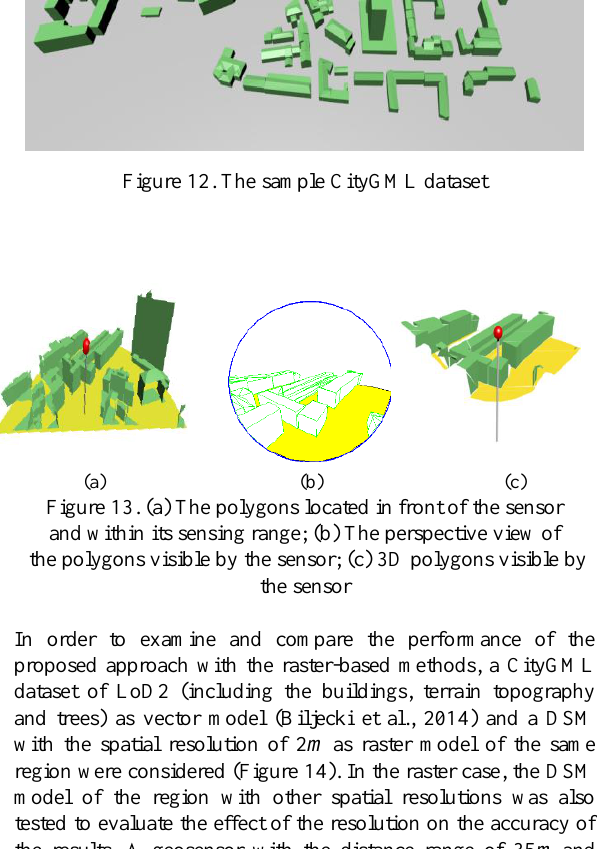
Figure 17. Comparison of the covered area in the raster (DSM) and vector (CityGML)